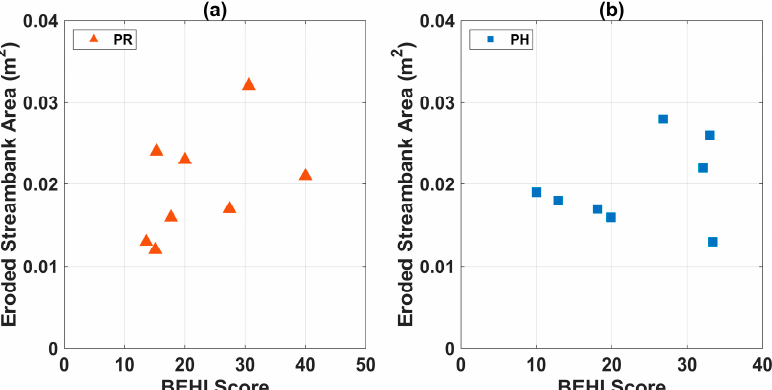
Figure 8. Correlation between BSTEM process-based predictions of eroded bank area at each cross- section and form-based BEHI scores for bank erosion potential for the ( a ) Post-Restoration (PR) and ( b ) Post-Hurricane (PH) geometries. Ratings for BEHI Scores are: Very Low (5–9.5); Low (10–19.5);